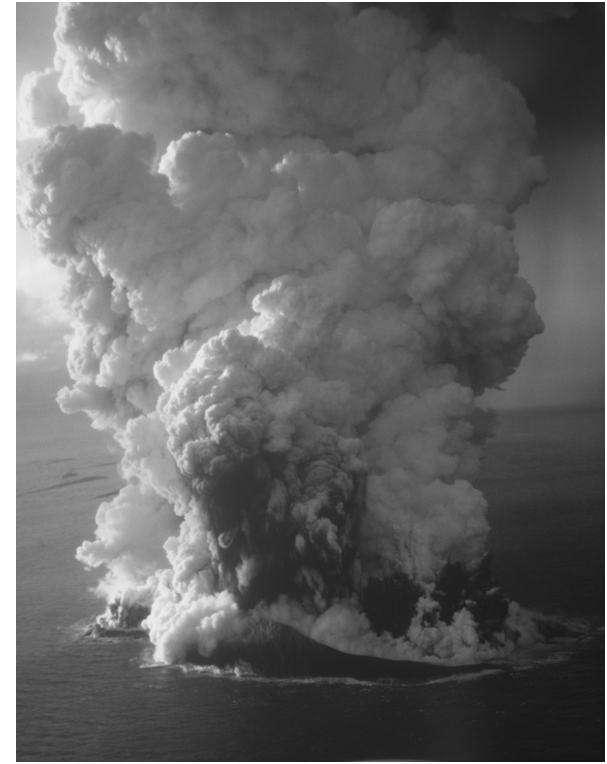
Figure 2. Surtsey Volcano in eruption, 30 November 1963 (Terry Mann, courtesy of Robert